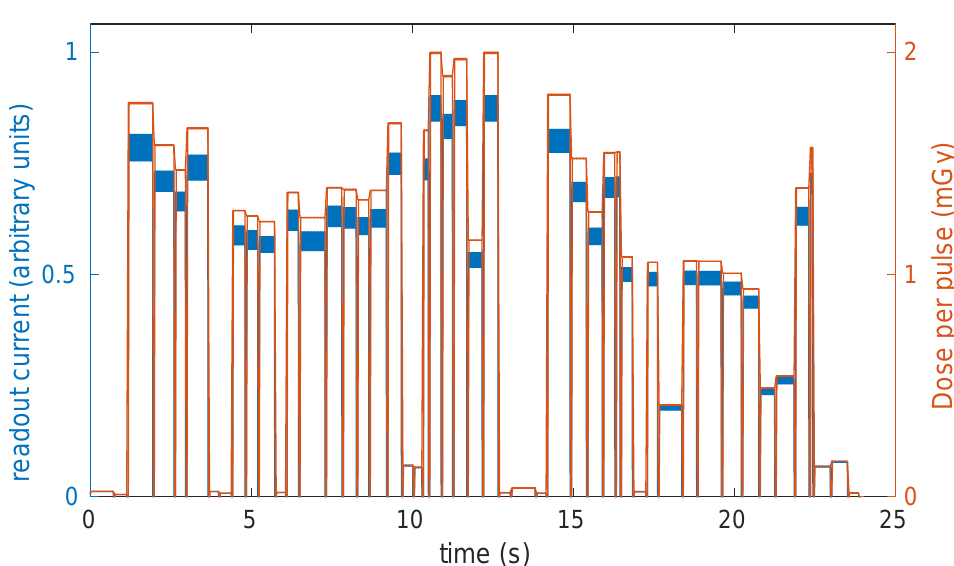
Figure 3. Simulated readout signal in a pixel of the LIC operating at 1000 V and irradiated by a beam simulating a delivery with a maximum dose per pulse of 2 mGy (roughly corresponding to a delivery at 10 MV-FFF in a TrueBeam linac) and 2.8 ms between pulses (blue line). The corrected signal is also shown (red line), as well as the variation of the dose per pulse during the irradiation. It is observed that the larger the dose per pulse, the more important the difference between raw readout and collected readout (due to increased